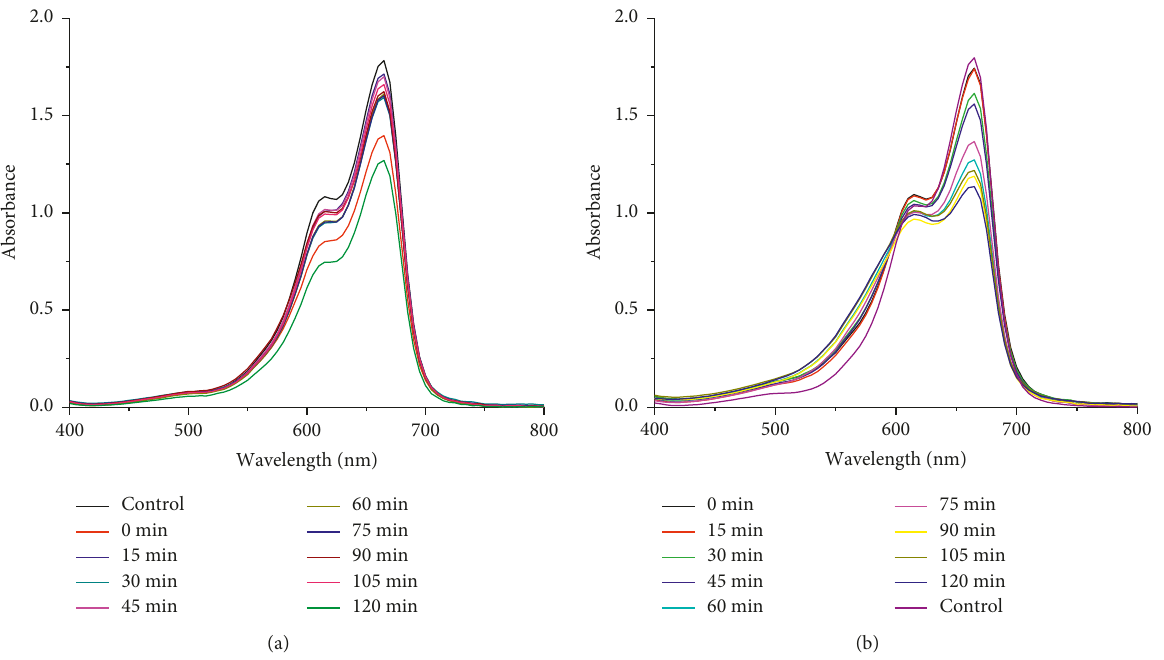
Figure 3: Absorbance curves of MB solution (dark): (a) raw egg shell powder; (b) calcined egg shell